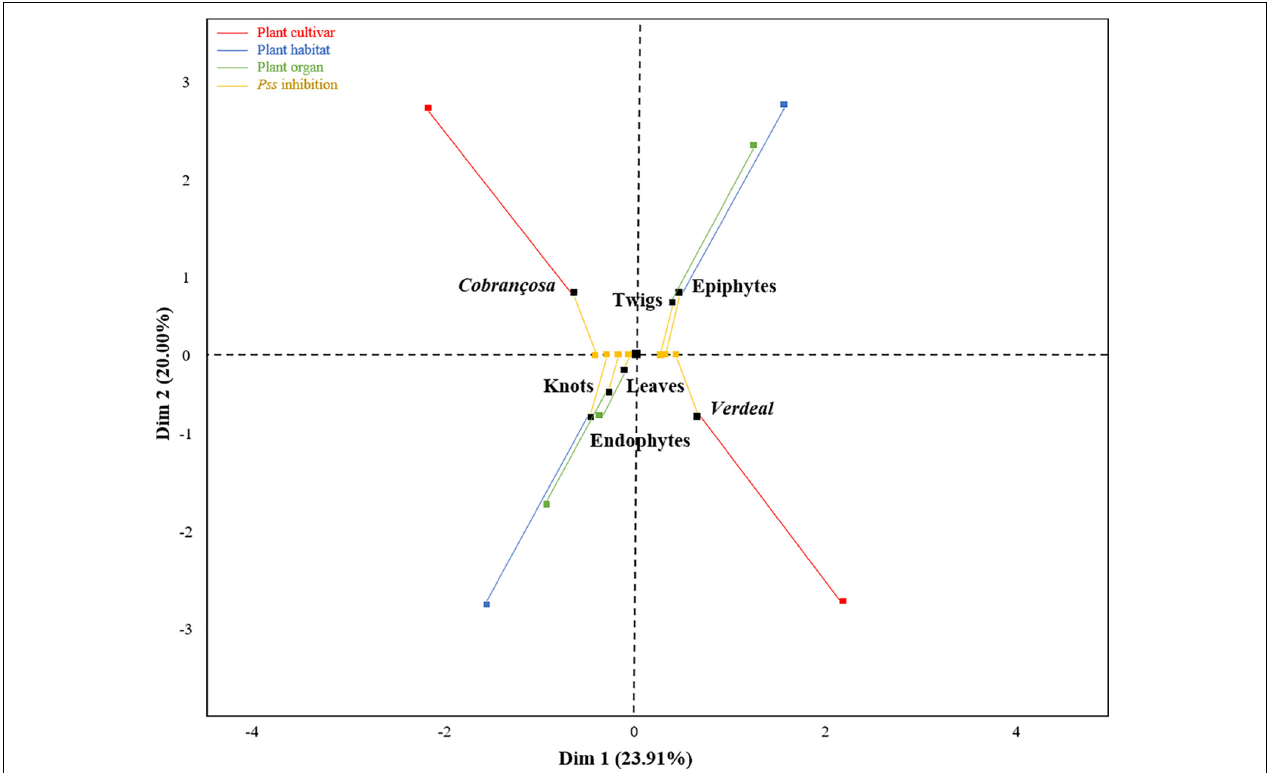
FIGURE 2 | Association of Pss growth inhibition ability of tested bacterial isolates with plant cultivars ( Cobrançosa and Verdeal Transmontana ), organs (leaves, twigs, and knots) and microbial habitats (epiphytes and endophytes), as revealed by a multiple factor analysis (MFA). The first two dimensions represent 43.91% of the total variance. Dimension 1 is associated to the inhibition ability of antagonists (contribution of 77.3%, p < 0.001), while dimension 2 is associated to microbial habitat (contribution of 42.7%, p < 0.001), cultivar (41.4%, p < 0.001), and organ (15.9%, p < 0.001). An individual (black square) is at the barycenter of corresponding partial points (colored squares), thus representing an individual as seen by a single group. Therefore, each black square represents an individual viewed by two groups of variables: Pss inhibition (yellow squares) and their presence regarding cultivar (red squares)/microbial habitat (blue squares)/plant organ (green